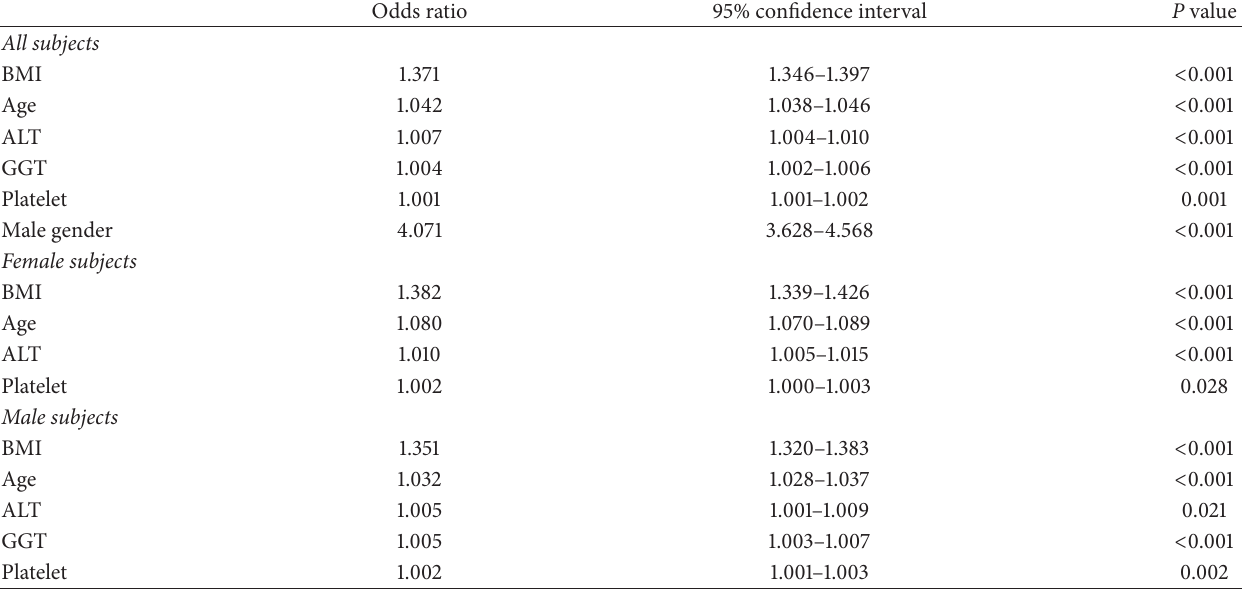
Table 7: Risk factors of metabolic syndrome in subjects with non-fatty liver disease by multivariate analysis. Odds ratio